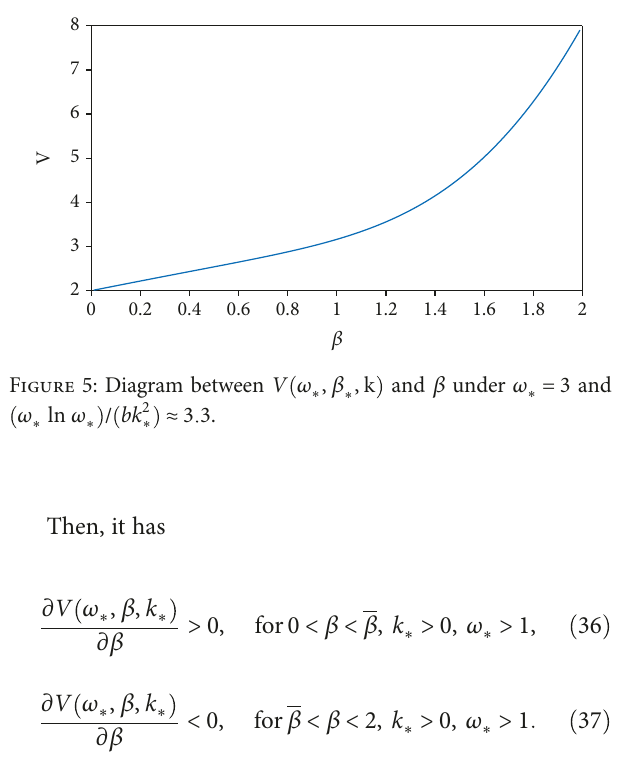
Figure 7: Diagram between V ω